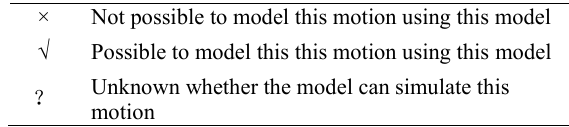
Table 1. Rating scheme of simulation models on motions